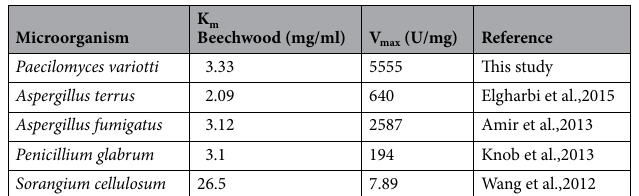
Table 5. Comparison of characteristic of xylanase enzymes purified from different